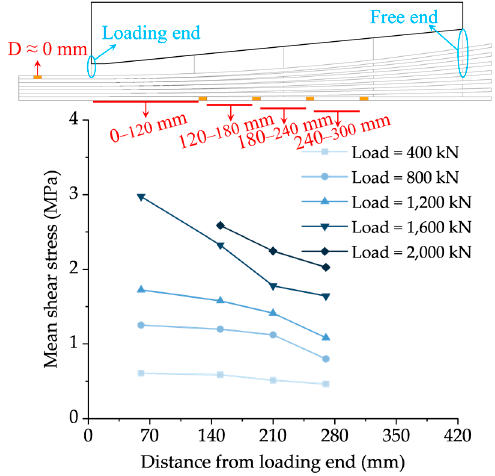
Figure 17. Mean shear stress of T-1 at different load grades.